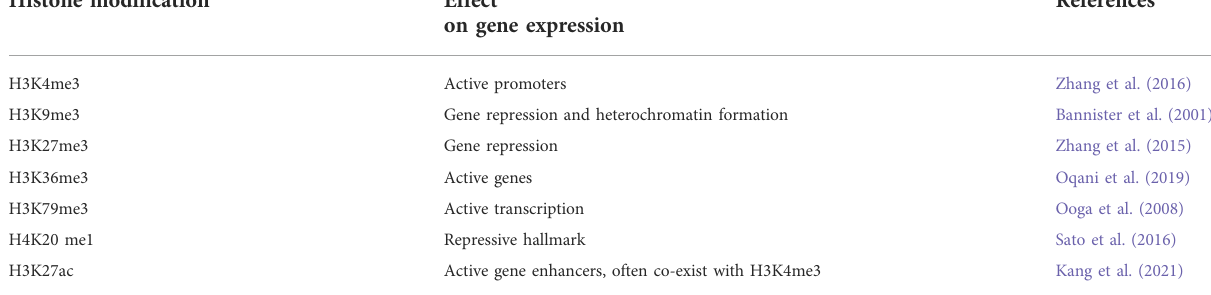
TABLE 7 Patterns of histone modi fi cation and regulation of gene